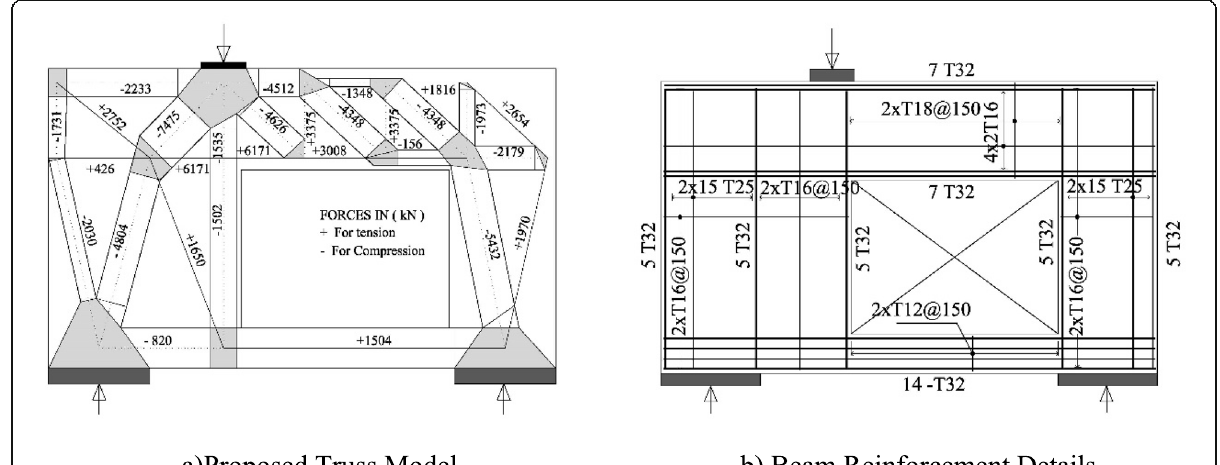
Fig. 4 Proposed Truss model for STM (ACI 318-14). a Proposed Truss model. b Beam reinforcement